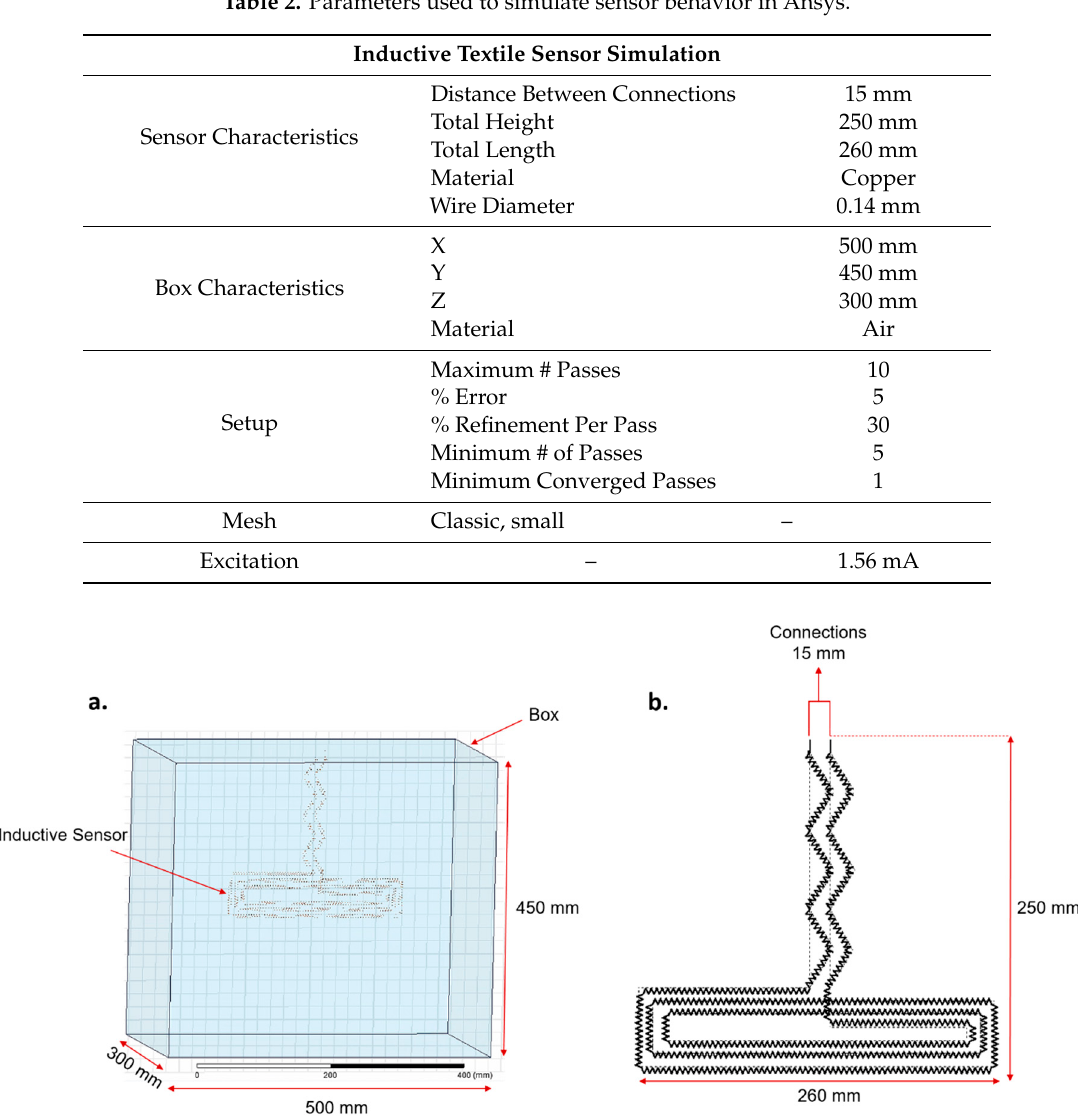
Figure 4. Ansys simulation of the inductive sensor: dimensions of the ( a ) box, ( b ) inductive sensor. Table 2. Parameters used to simulate sensor behavior in Ansys.